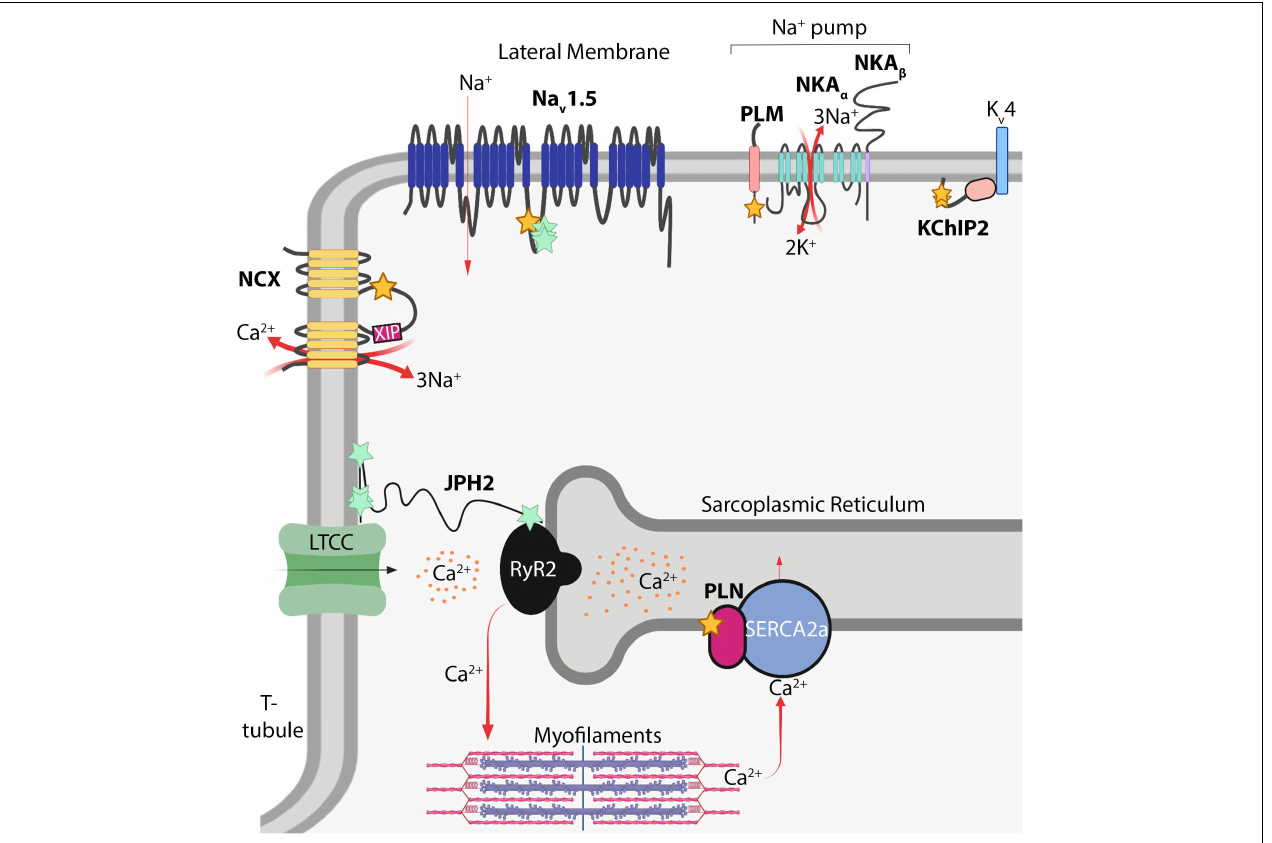
FIGURE 2 | S-acylation in myocardial electrophysiology. Schematic of S-acylated ion channels, transporters, and auxiliary proteins in cardiomyocytes. Yellow stars denote cysteines modified by S-acylation; turquoise stars denote potential modification sites. NCX , Na + /Ca 2 + -exchanger; XIP , exchanger inhibitory peptide; Na v 1.5 , voltage-gated Na + channel; PLM , phospholemman; NKA , Na + /K + -ATPase; KChIP2 , K + channel interacting protein 2; K v 4 , delayed rectifier voltage-gated K + channel; PLN , phospholamban; RyR2 , ryanodine receptor 2; SERCA2A , sarcoendoplasmic reticulum ATPase 2A; JPH2 , junctophilin-2; LTCC , voltage-gated L-type Ca 2 + channel. Image created with BioRender